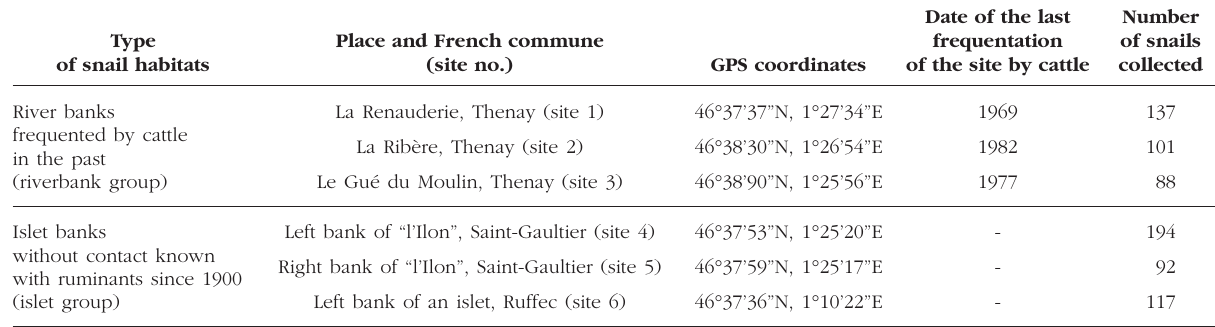
Table I. – Main characteristics of the six snail habitats studied along the Creuse River in the department of Indre (central